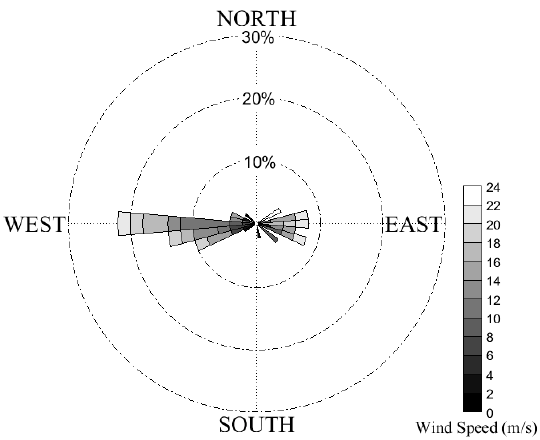
Figure 6. The background wind in the stratosphere above the convective system at 18:00 LT on 10th August.